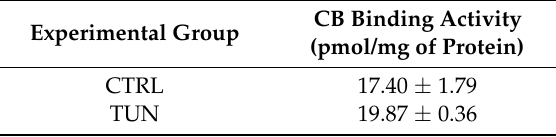
Table 3. CB 1 and CB 2 binding activity of control SH-SY5Y cells, and of cells treated with tunicamycin (TUN 1 µ g/mL) for 24